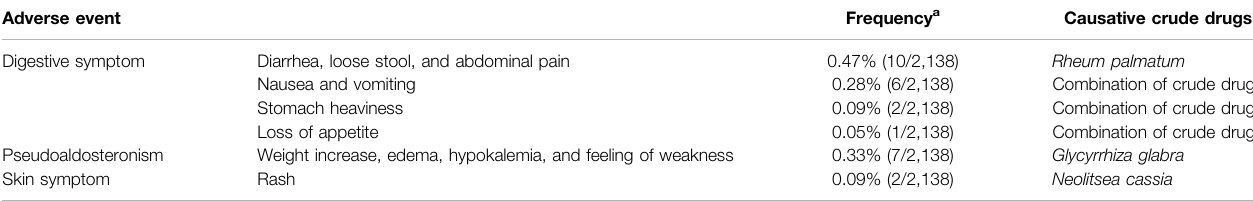
TABLE 5 | Adverse events related to